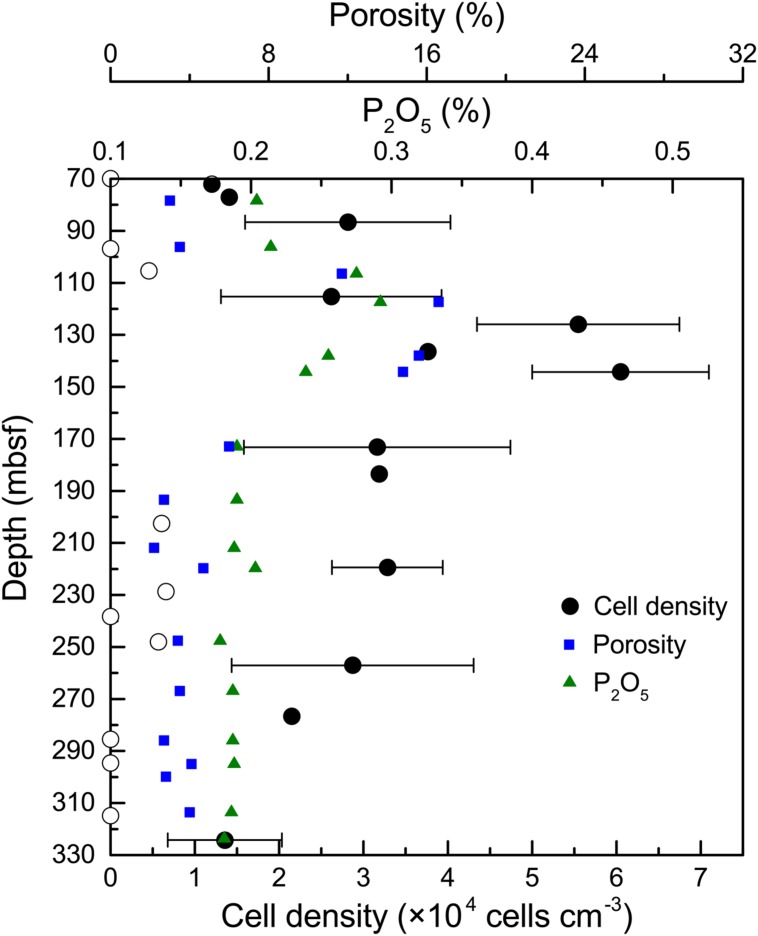
Microbial abundance in basalt samples from Hole U1383C. The cell counting data are averages of three determinations. The error bars indicate the standard deviations of the cell counts. Open circles indicate suspicious values near or below the detection limit (∼103 cells cm-3). Porosity and P2O5 content of the basalts are from Expedition 336 Scientists (2012c).